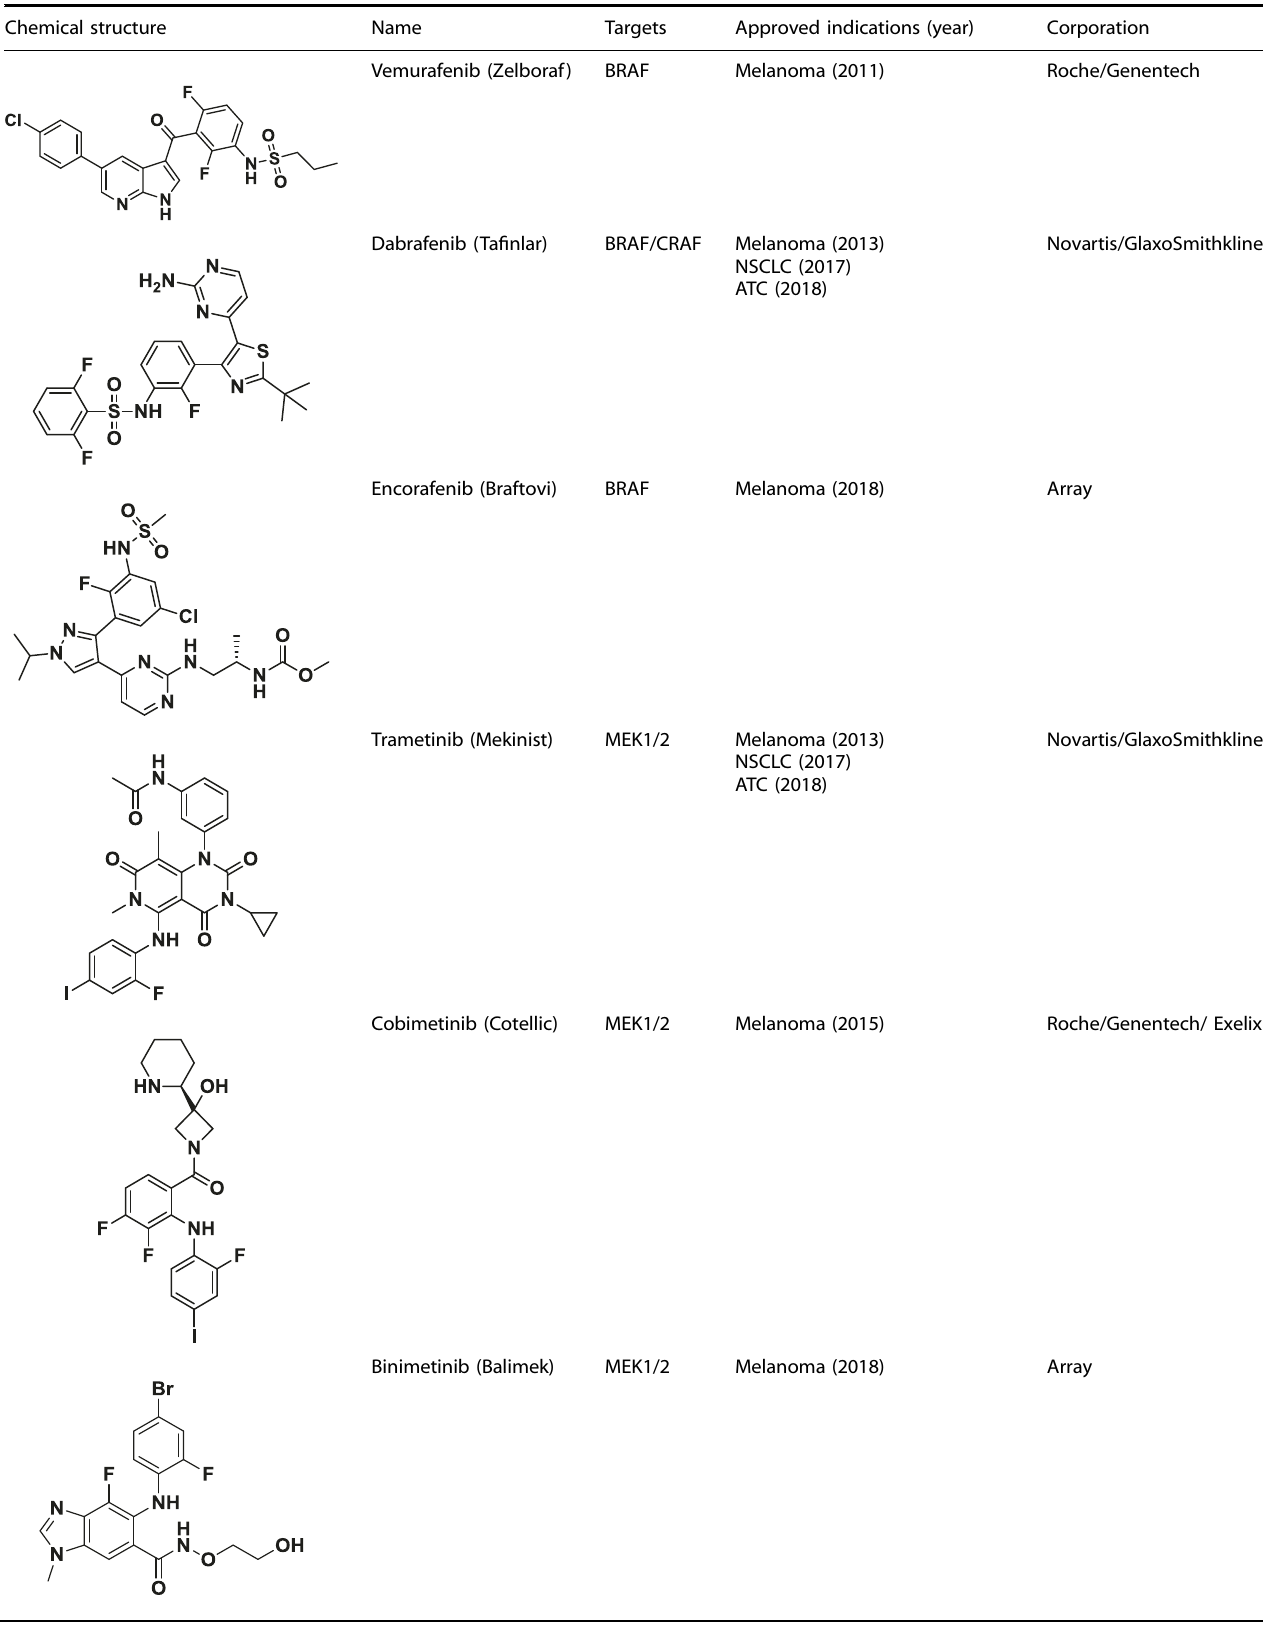
Table 3. Properties of approved small-molecule inhibitors of serine/theonine kinases Chemical